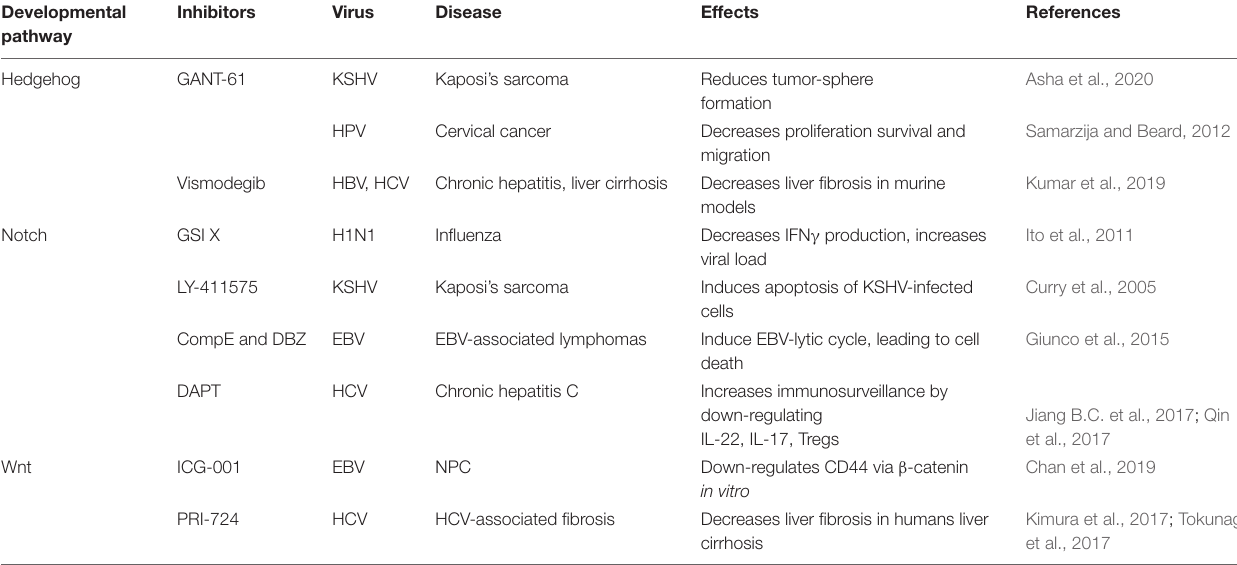
FIGURE 5 | Developmental pathways co-opted during viral oncogenesis. Viruses deregulate developmental signaling to support malignant transformation and disease progression, via a variety of mechanisms, including (but not limited) to, increased proliferation and cell survival, induced stemness to improve fitness of the cancer cells, accrued neo-vascularization, activation of the epithelial-to-mesenchymal transition (EMT), evasion of tumor-targeting immune response. Inhibitors of developmental pathways may prevent the acquisition of new properties by the cancer cells, such as virus-induced transcriptional, metabolic, and functional reprogramming. Each color is associated with a specific virus and the cell processes controlled the developmental pathway. TABLE 1 | Inhibitors of developmental pathways as therapeutic strategies in viral